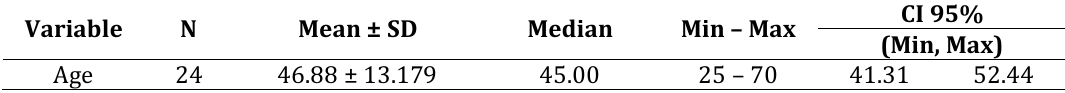
Distribution of respondent characteristics based on age at the Kidney Clinic and Sustainable Hypertension October 2022 (n=24)